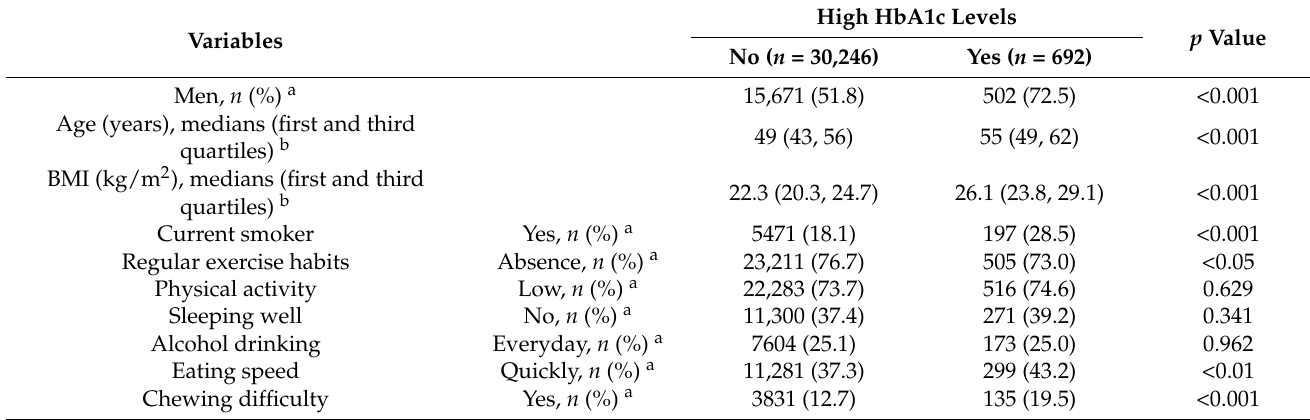
Table 2. Characteristics of the study populations with and without high HbA1c levels.